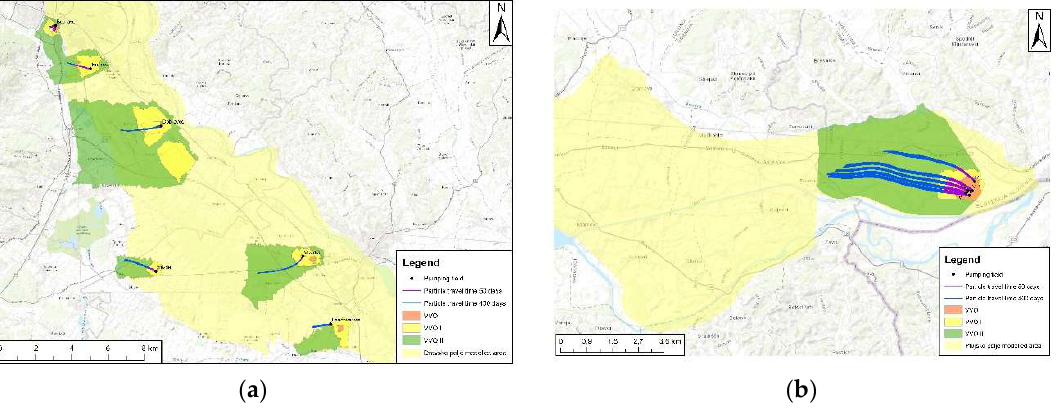
Figure 10. ( a ) Modelled travel times for the Dravsko polje aquifer; ( b ) Modelled travel times for the Ptujsko polje aquifer.